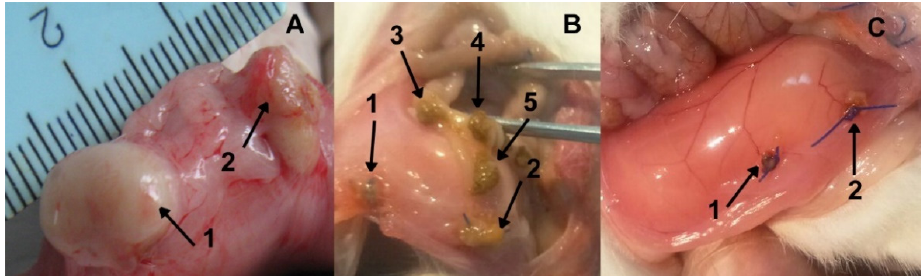
Figure 25. Suppressing EMT proliferation in rats with surgically induced endometriosis using DNICs with glutathione. ( A ) Proliferation of original 2 mm endometrial implants (arrows 1 and 2) on the inner surface of the abdominal wall during one month of control; ( B ) A similar picture with secondary tumors (arrows 1–5); ( C ) Suppressing proliferation of endometrial implants in case of daily intra-abdominal administration of 10 μ mol of DNICs with glutathione per 1 kg of an animal’s weight for ten days, which started in four days after the surgery (arrows 1 and 2). Photocopies were made a month after the surgery.